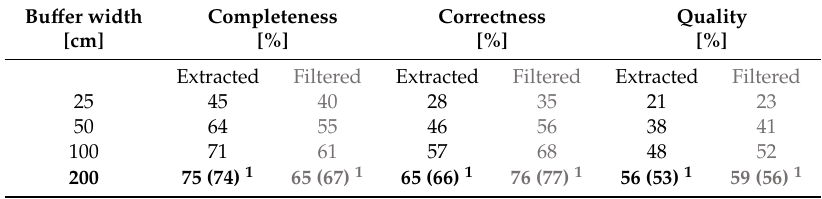
Table 4. Accuracy assessment of boundary extractions for a GSD of 50 cm, scale 80, merge 95.